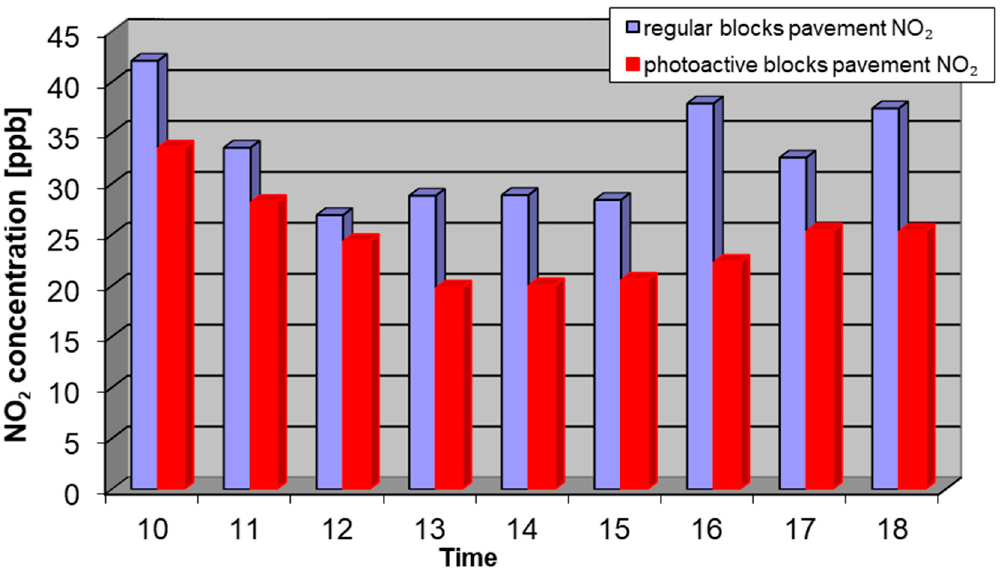
Figure 7. Average concentration of NO 2 on 12 September, 2018 from 10 a.m. to 6 p.m. at the regular pavement (blue) and photocatalytic pavement (red).